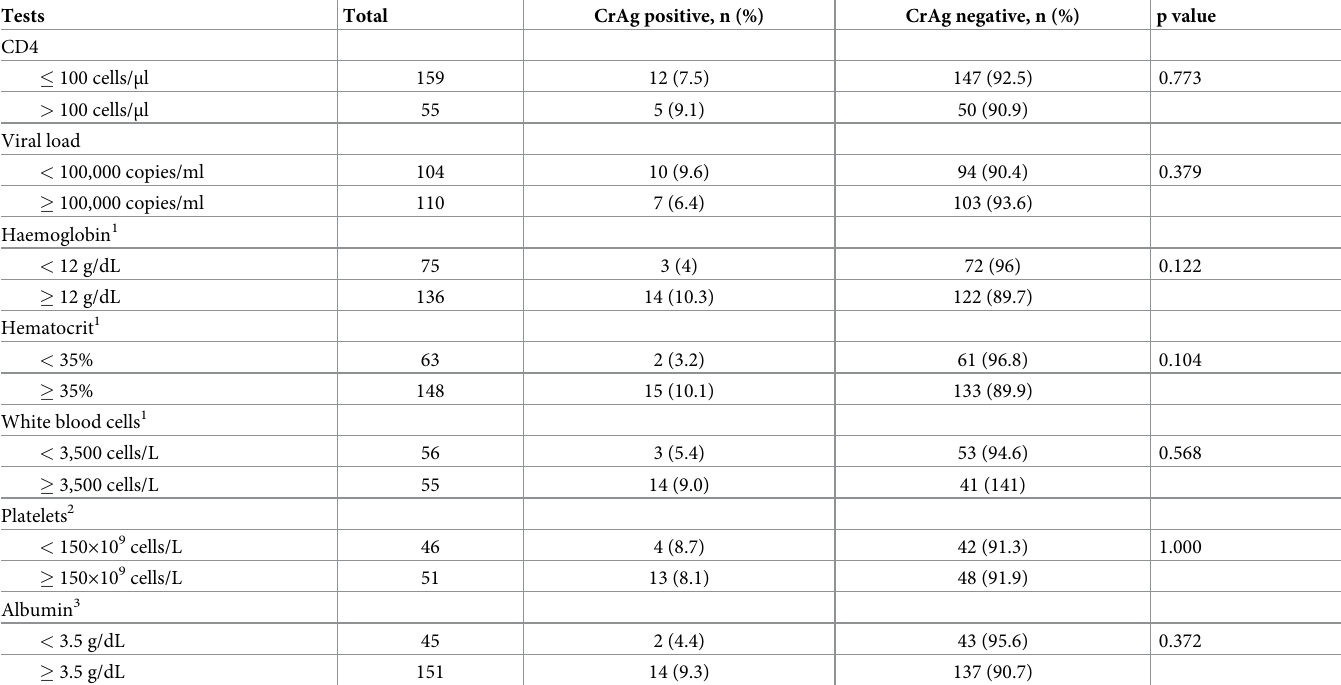
Table 2. Laboratory tests of the 214 individuals screened with serum